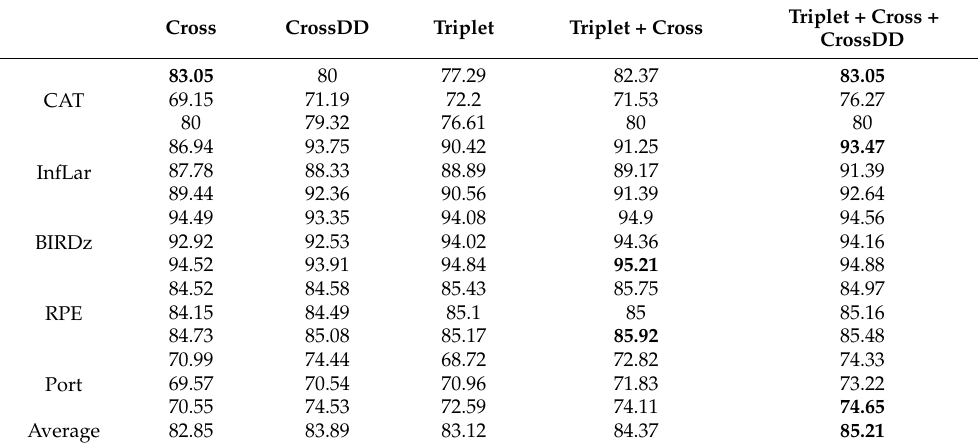
Table 1. Performance of the two tested loss functions (boldface represents the best